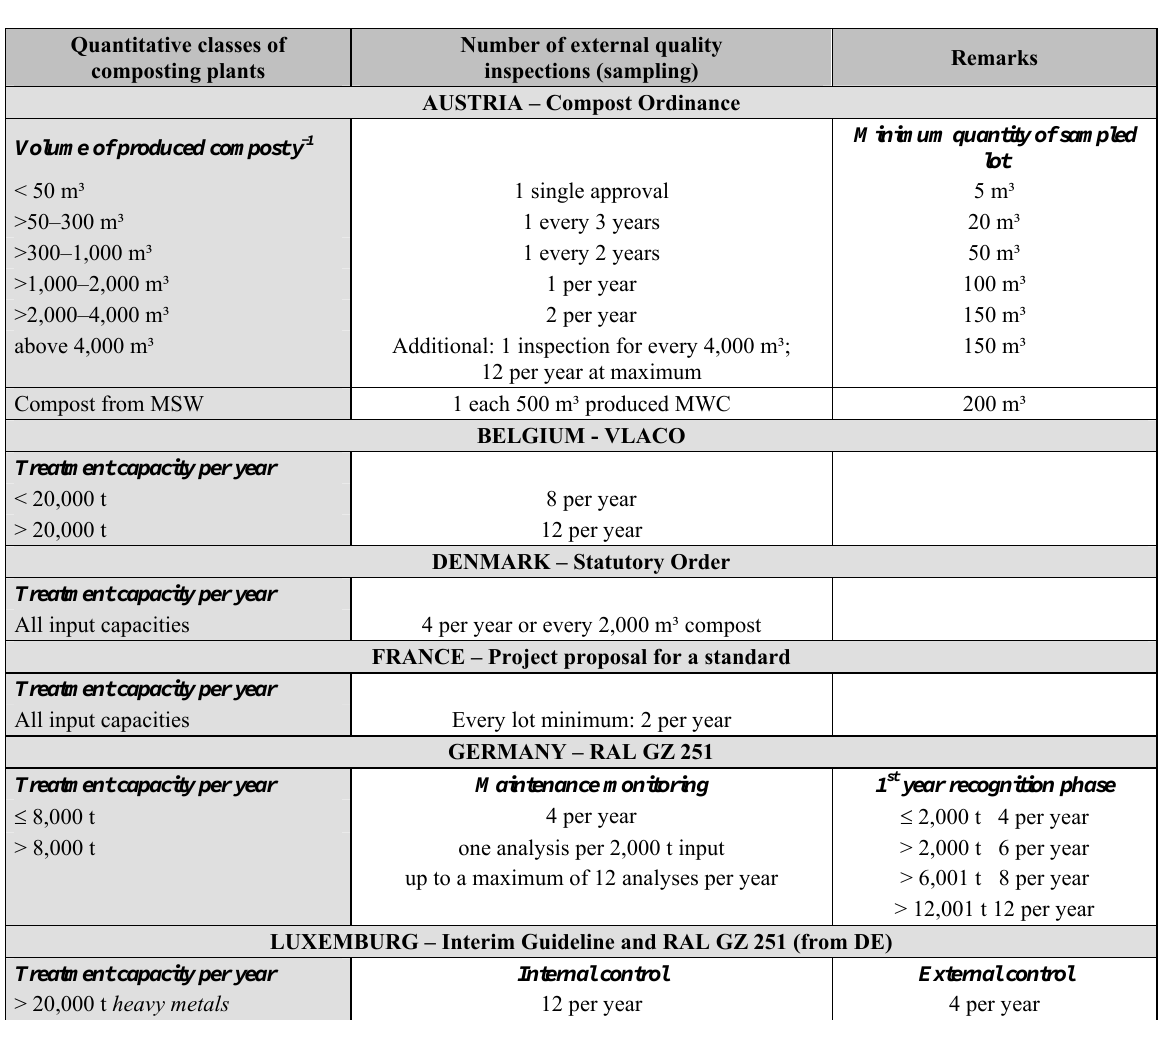
Frequency of sampling related to the yearly materials throughput or